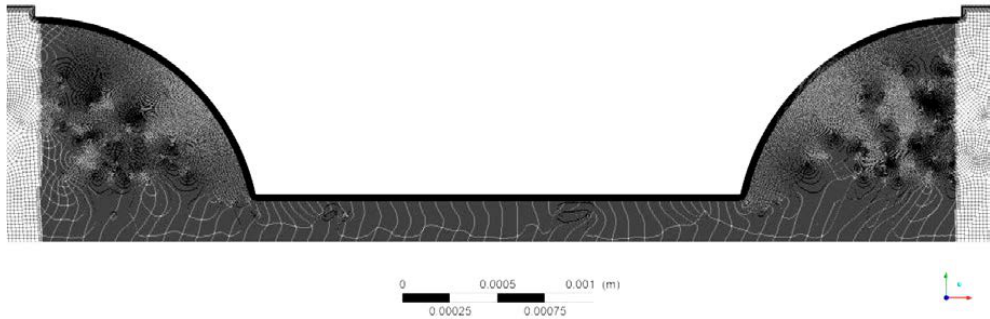
Figure 4. 2D axis-symmetrical unstructured mesh with quad type elements of the nozzle flow domain. The mesh is refined in the circular section near the entrance and the exit of the orifice and in the orifice region.